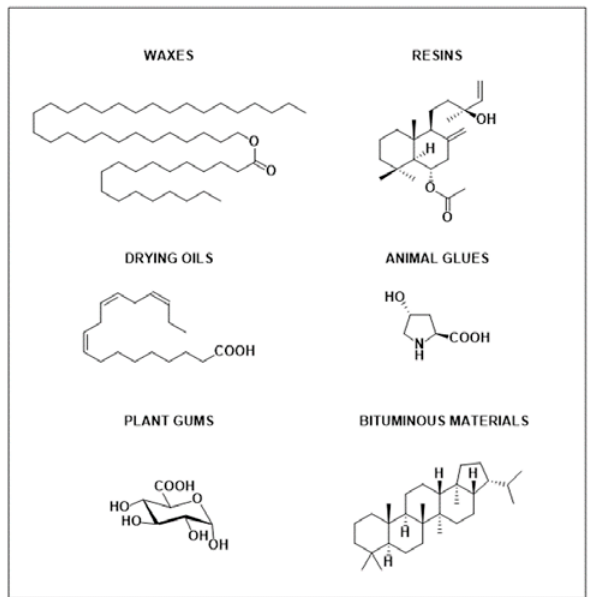
Figure 1. Representative constituents of natural organic binding media. (i) Waxes: Triacontanyl palmitate (in bees wax). (ii) Diter- penoic resins: Larixyl acetate (in Venetian turpentine). (iii) Dry- ing oils: Linolenic acid (9,12,15 octadecatrienoic acid (in linseed oil). (iv) Animal glues: Hydroxyproline (in collagens). (v) Plant gums: Glucuronic acid (in gum Arabic). (vi) Bituminous materials: Hopane in